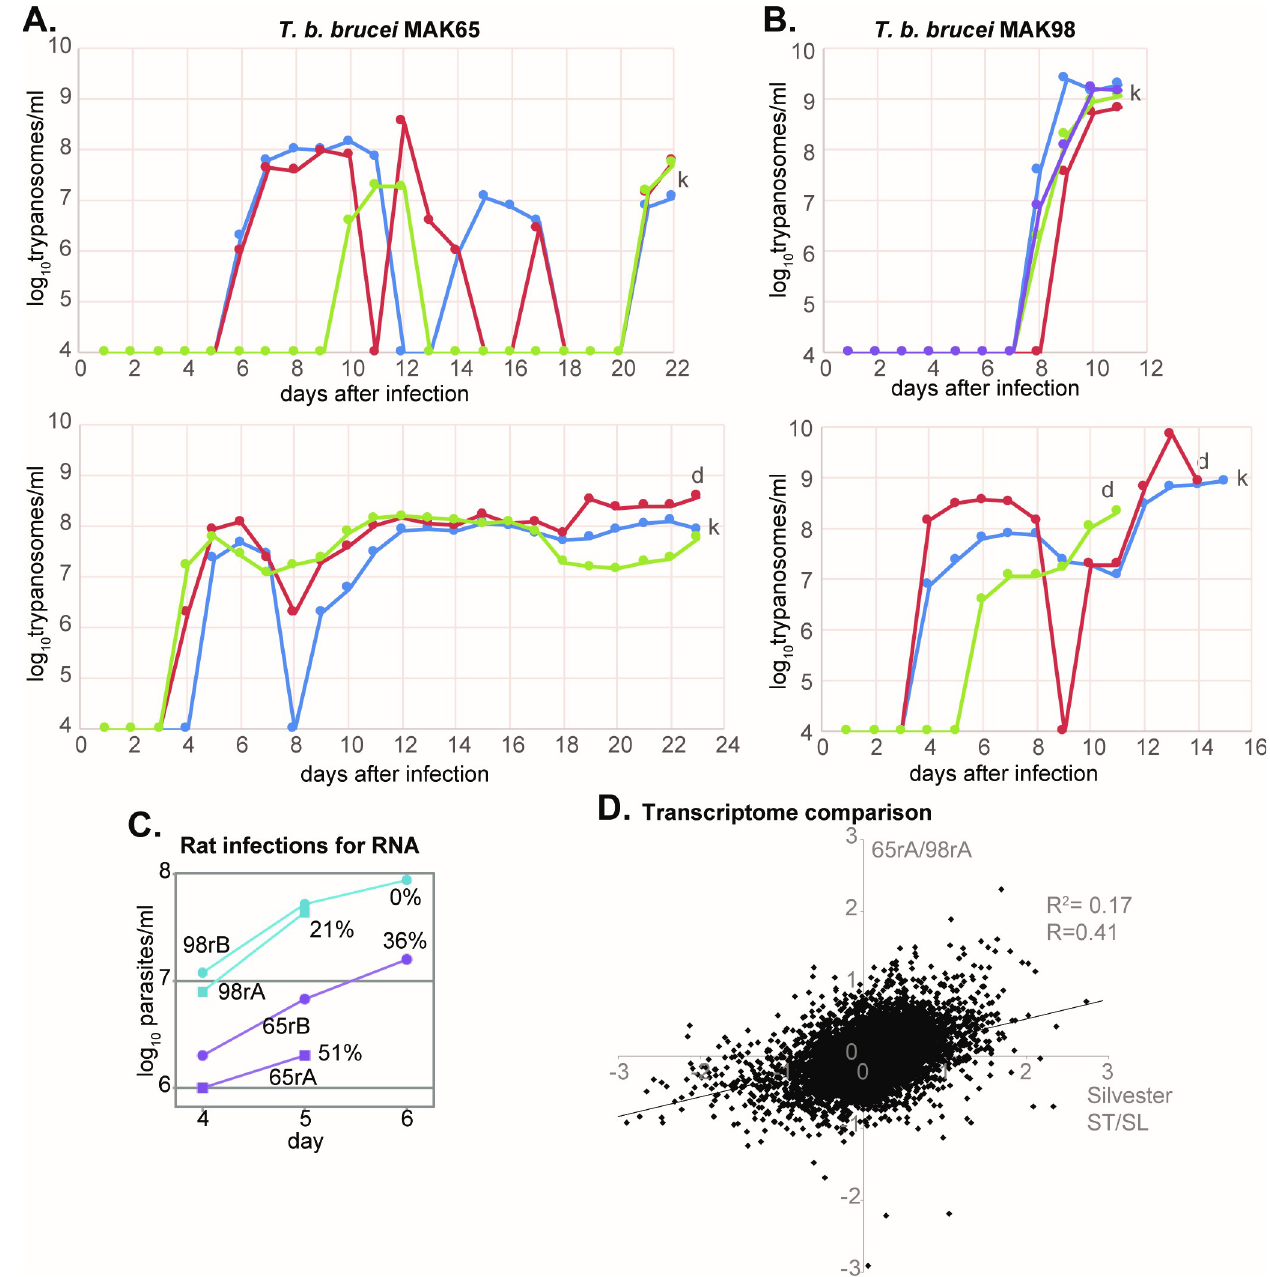
Fig 2. Growth of MAK65 and MAK98 strains in rodents. A. Parasitaemias after infection of three or four mice with 1,000 strain MAK65 parasites. "d" indicates death and "k" indicates killing because of clear symptoms. The y axis scale is the log10 of the parasitaeimia. B. Parasitaemias after infection of 3 mice with 1,000 strain MAK98 parasites. C. Growth of both strains in rats before harvest for RNA purification. The percentage of PAD1 positive cells at the time of harvest is indicated. D. The transcriptomes of population 65 (rat A) and 98 (rat A) parasites (panel C) were compared and the log2 ratio (65A/98A, S1 Table, sheet 1) is on the y-axis. The x-axis shows published stumpy/long slender results for trypanosomes grown in mice [22]. The correlation coefficients are from linear regression analysis using the log-transformed rations, and were generated in Microsoft Excel.